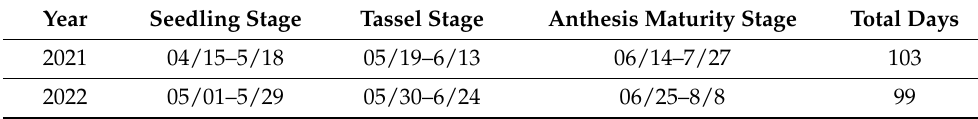
Table 4. Division of growth stages of the two maize